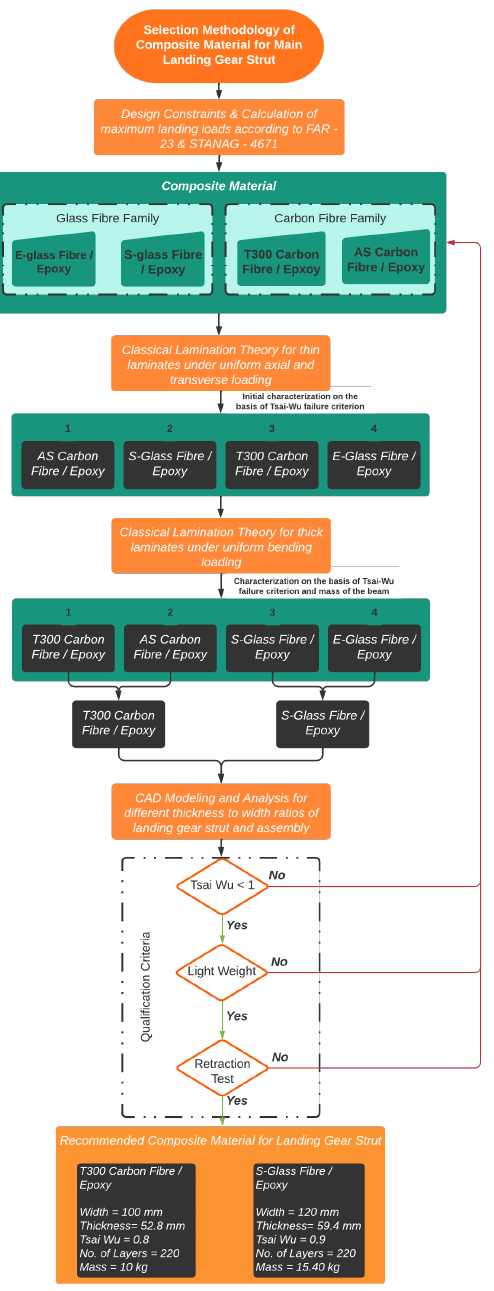
Figure 2. Proposed methodology for selection of composite material for manufacture of main landing gear